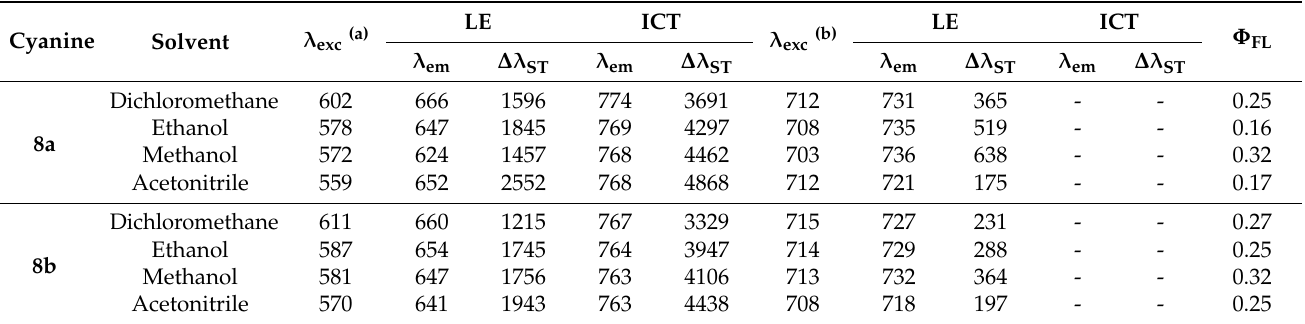
Table 3. Excited-state photophysical data of meso -substituted heptamethine cyanine dyes 8a-b in solution, where λ em is the emission maximum (nm) at different excitation wavelengths ( λ exc in nm), − 1 ), and Φ ∆ λ ST is the Stokes shift (cm FL is the fluorescence quantum